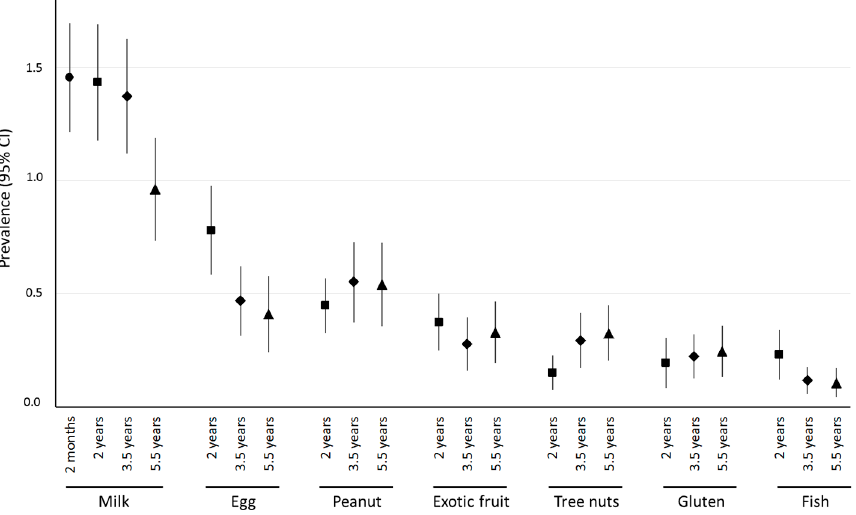
Figure 1. Prevalence of allergy to specific allergens at each time point (circle: 2 months ( n = 15,785), square: 2 years ( n = 12,537), diamond: 3.5 years ( n = 11,389) and triangle: 5.5 years ( n = 10,987) of age). CI: Confidence Interval